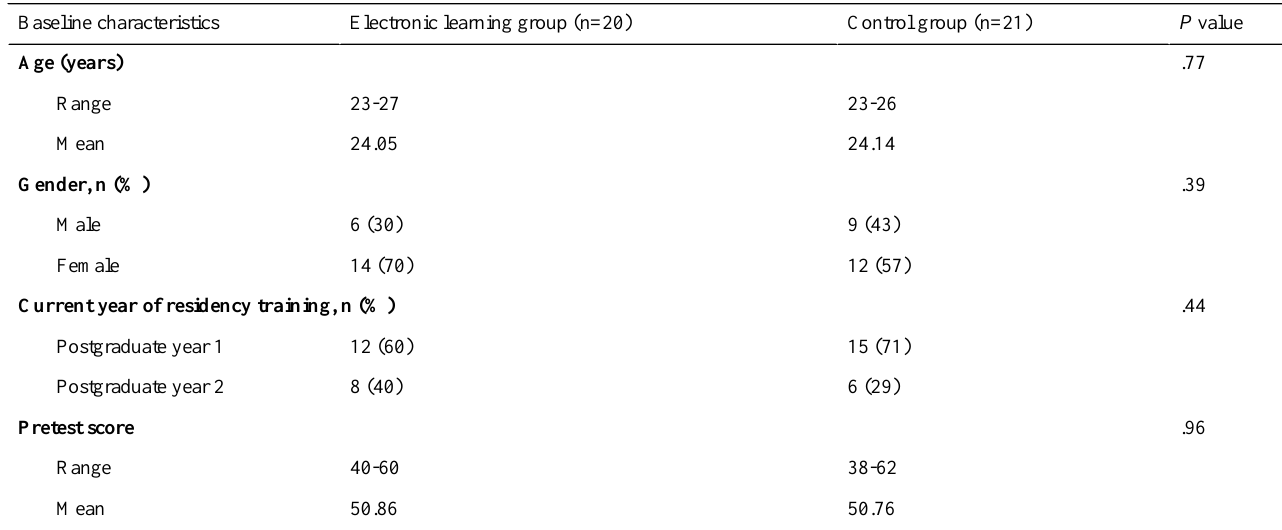
Table 1. Demographic and other characteristics of